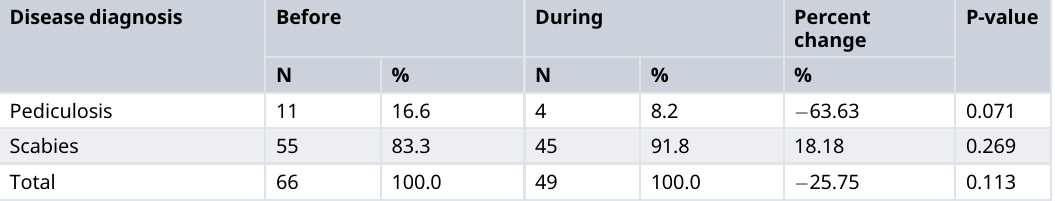
Table5.Thetrendofcutaneousparasiticinfectionbeforeandduringthecoronavirusdisease2019(COVID-19) pandemic.